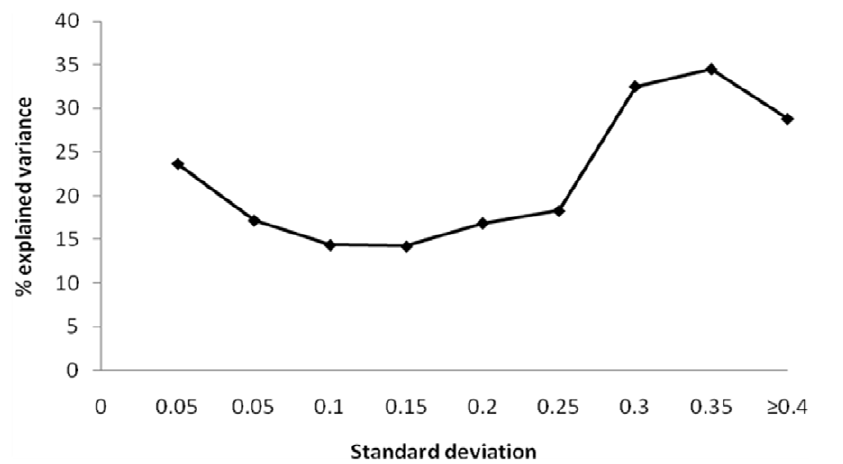
Figure 2. Mean values of standard deviation in environmental variables (for detailed description of variables see Table 1). For convenience, values are presented as averages in intervals of 0.05. Pearson’s correlation between SD and % explained variance is